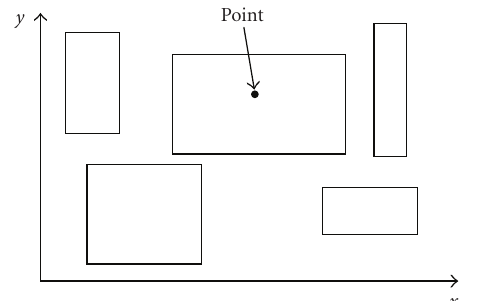
Figure 1: Example for 2-dimensional point locating problem.